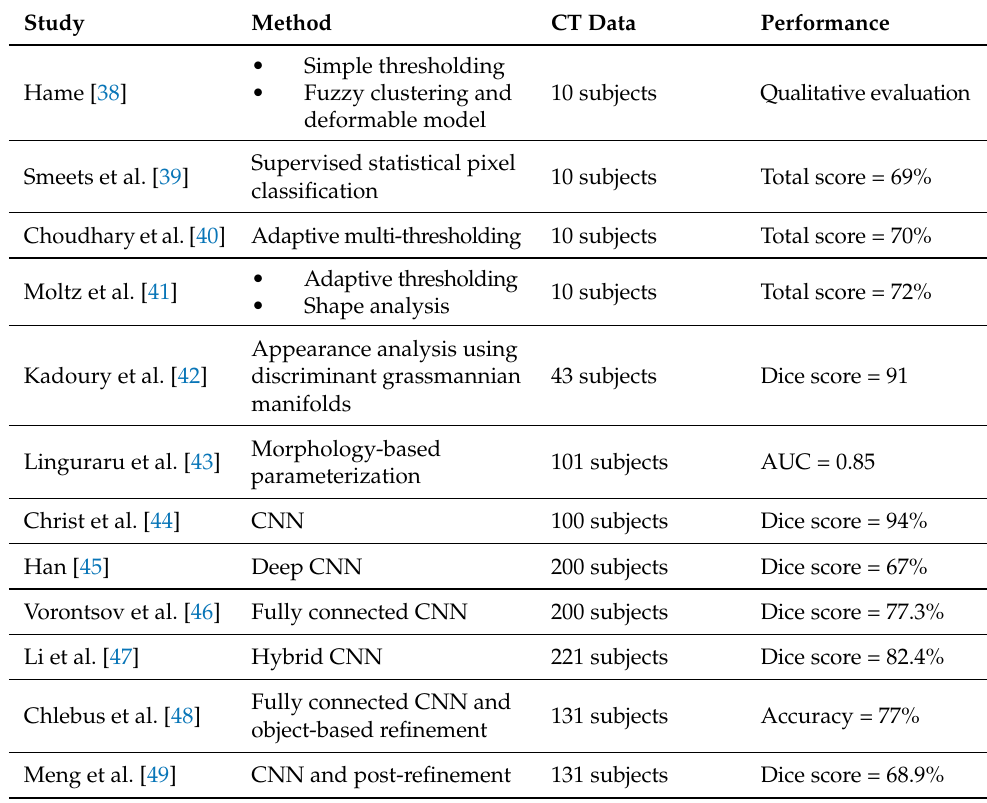
Table 1. Segmentation of Hepatic Focal